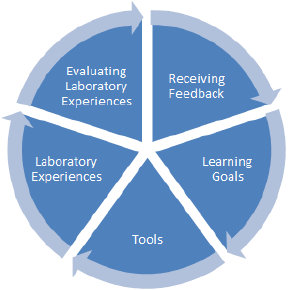
Figure 1. Stages of the